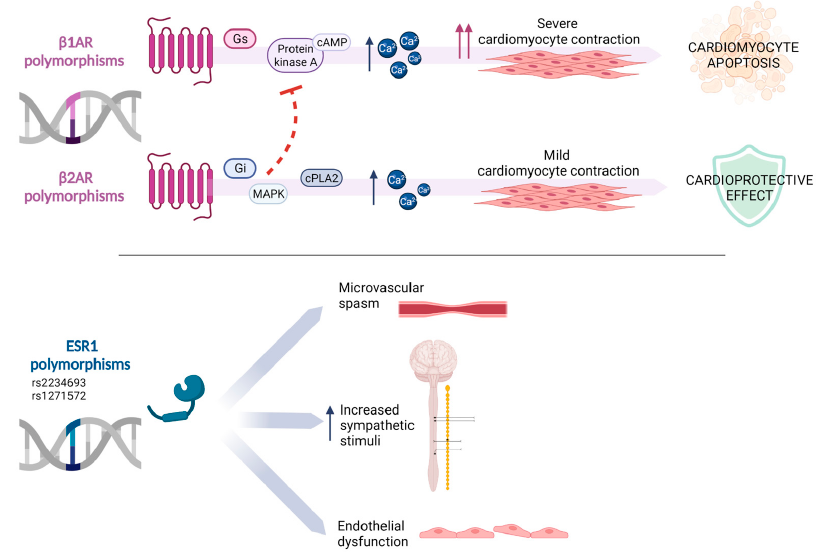
Figure 2. Genetic susceptibility in the pathogenesis of TC: Adrenergic Receptor β 1, β 2 (AR β 1, AR β 2), and Estrogen Receptor Gene 2 (ESR2) polymorphisms could explain the cardiotoxicity observed in TC patients. Stimulatory G protein (Gs), cyclic Adenosine MonoPhosphate (cAMP), mitogen-activated protein kinase (MAPK), cytosolic phospholipase A2 (cPLA2). Created with Bio- Render.com .